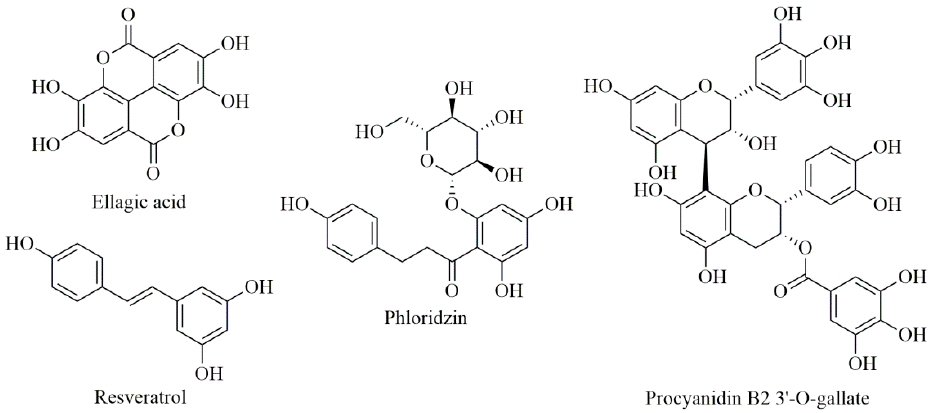
Figure 2. Chemical structures of ellagic acid, phloridzin, resveratrol, and procyanidin B2 3’- O -gallate.